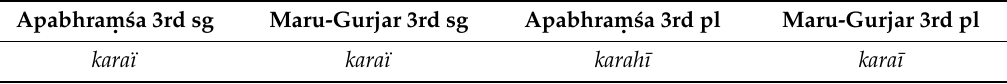
Table 1. Present tense of Apabhram. ´sa and Maru-Gurjar verb in third person singular and plural. 9